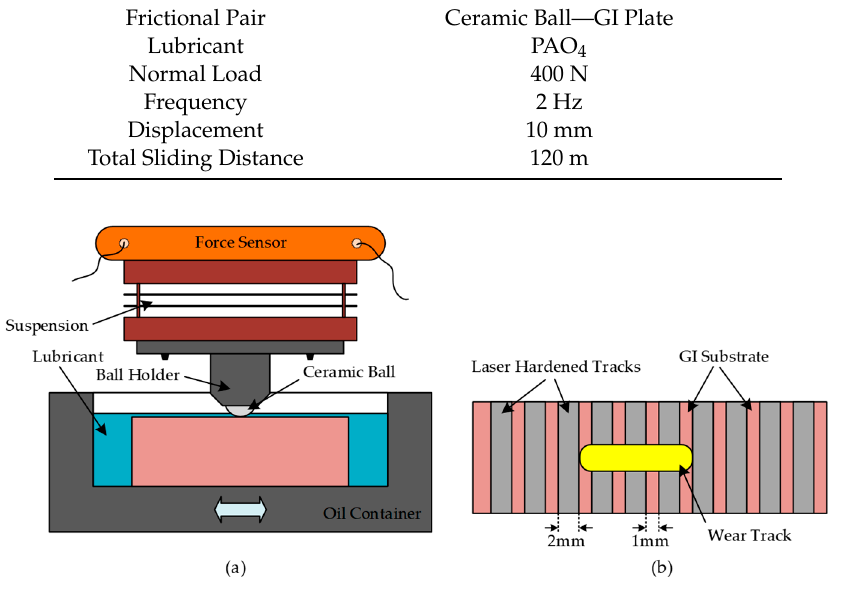
Table 2. Parameters in the Ball-on-Plate Reciprocating Sliding Wear Tests. GI: Gray Cast Iron. Frictional Pair